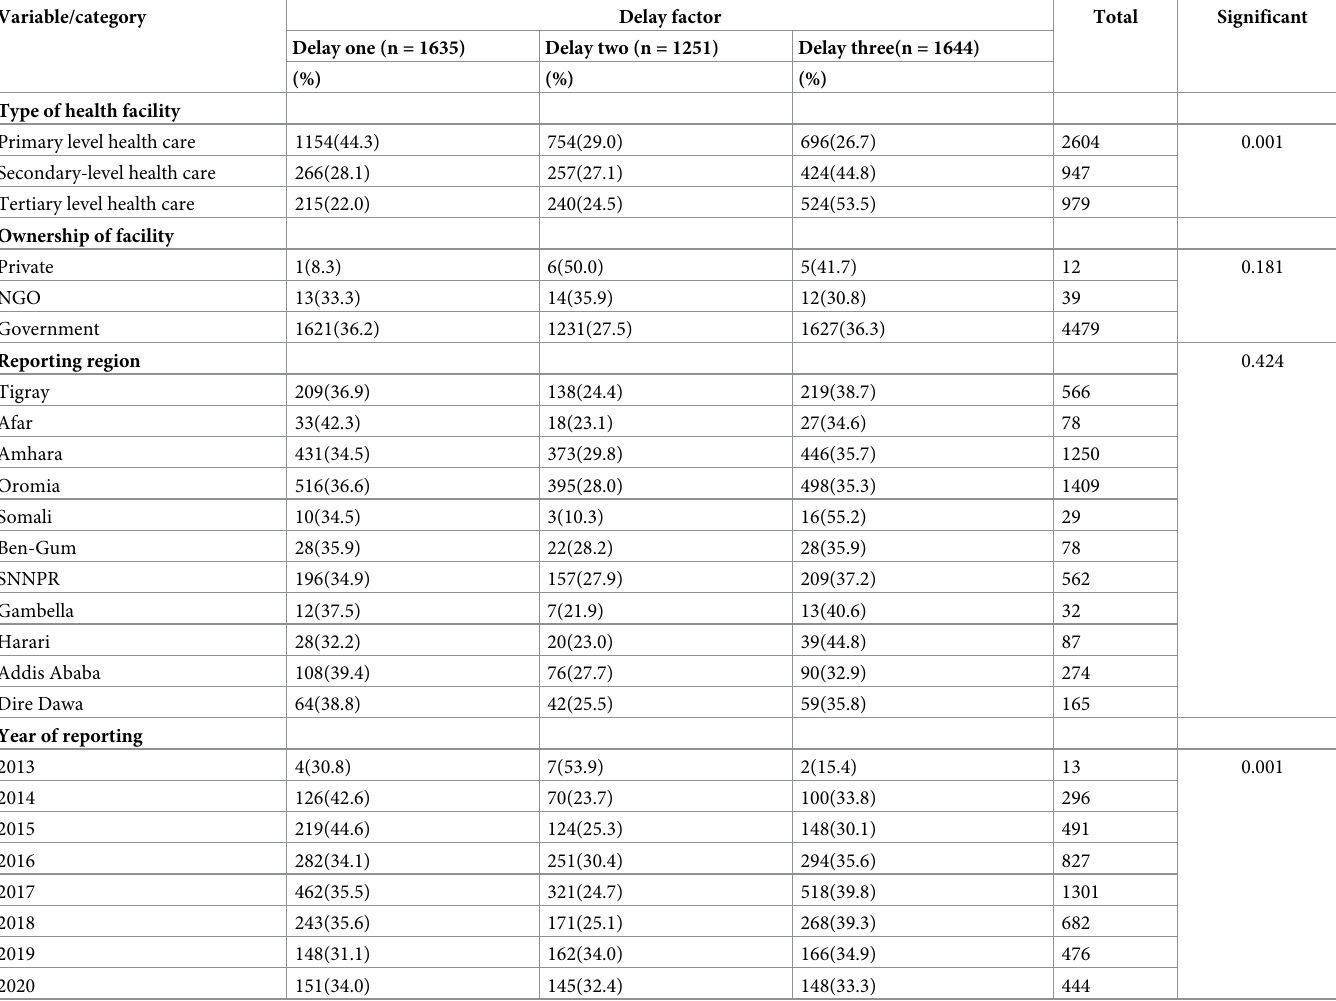
Table 1. Selected background characteristics of reporting facilities by the delay factor in Ethiopia,